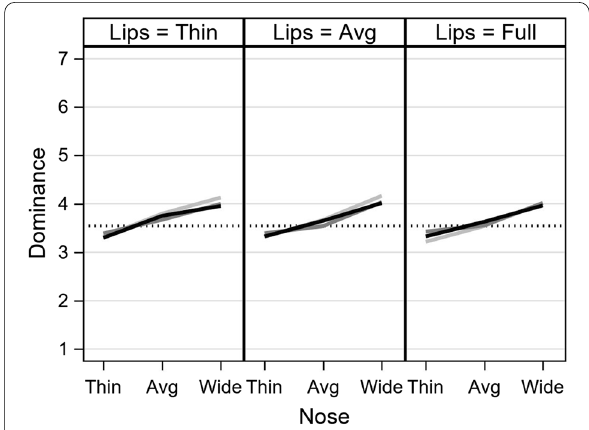
Fig. 2 Model‑predicted dominance ratings. The vertical axis is the predicted dominance score, with a dotted line for the model‑implied mean. The horizontal axis represents the levels of nose width. The three lines represent degrees of reflectance (none, medium, high). Each panel represents the degree of lip fullness